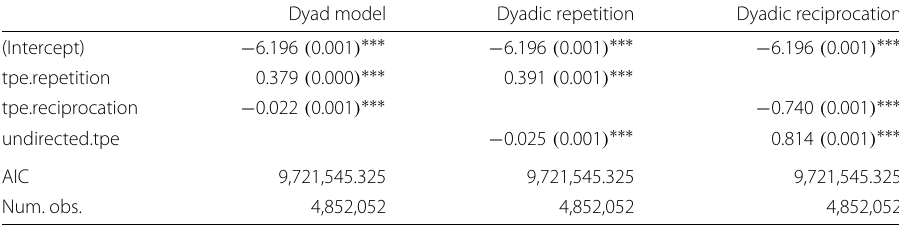
Table 5 Explaining third-party edit events by past third-party edits on the same dyad Dyad model